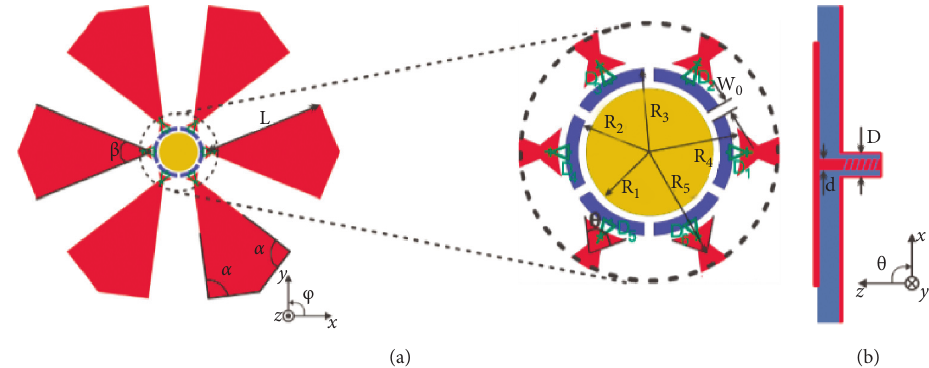
Figure 3: The designed reconfigurable antenna. (a) Top view. (b) Side